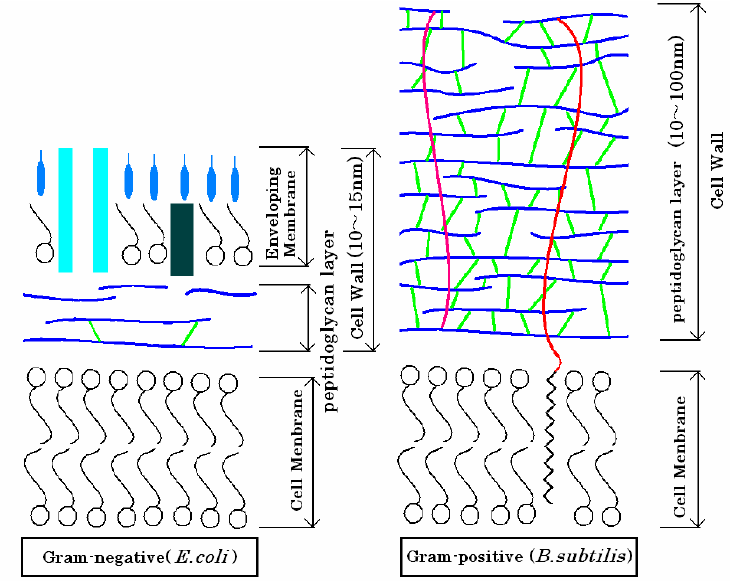
Fig. 17. Cell wall structure of two types of